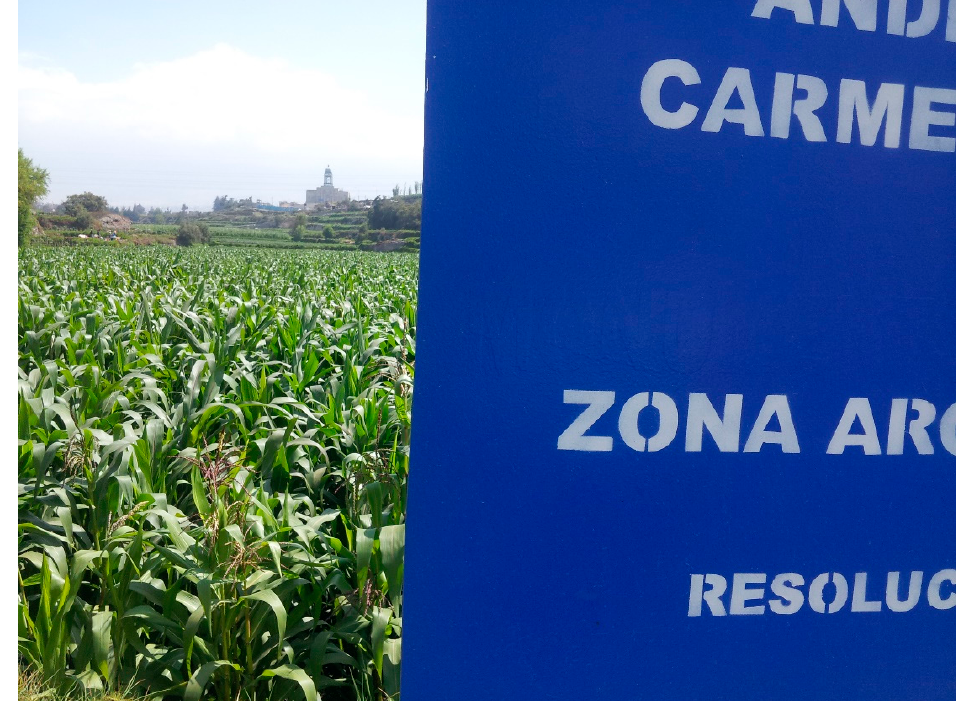
Figure 9. The Mormon temple emerges behind the very sign that once prohibited it. February 2018.